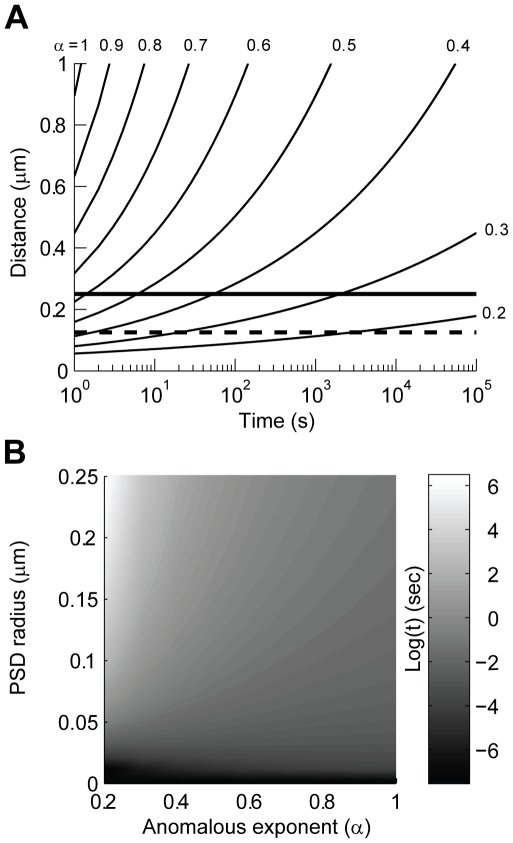
Anomalous diffusion could retain AMPARs inside a PSD for very long periods of time.
A: Distance as a function of time for a molecule undergoing anomalous diffusion. The plots were calculated using the anomalous diffusion equation (distance = √(4 Dfreetα), Dfree = 0.200×10−3 µm2/ms). We assumed an AMPAR released in the center of a typical PSD, the dashed line corresponds to the average diameter of a PSD (125 nm), while the thick line is for a large PSD (250 nm). B: Gray-scale plot of the Log(t) calculated using the same equation as in A. The plot shows the time a particle takes to reach the edge of a PSD after being released in the center. We calculated this value for a wide range of PSD sizes and anomalous exponent (α).